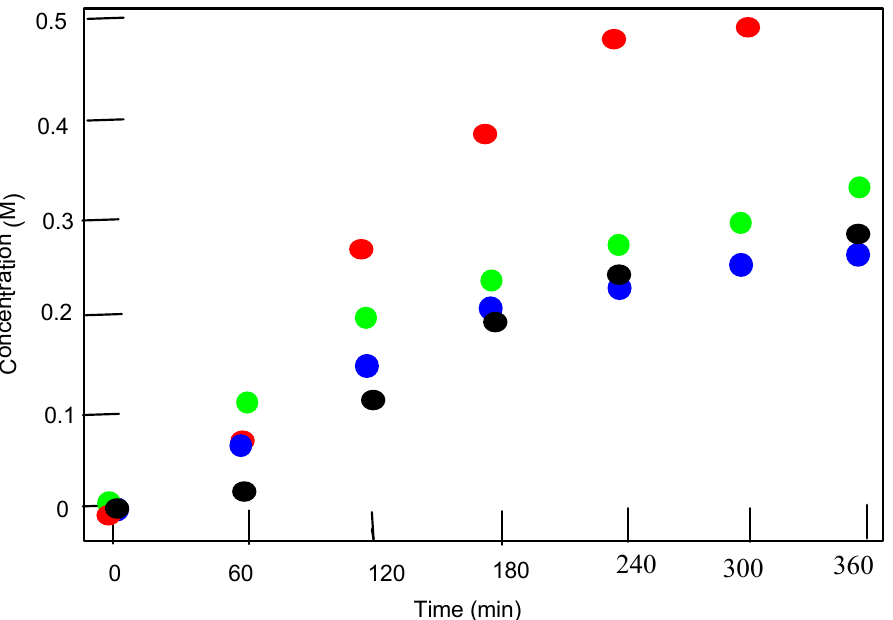
Figure 11. Accumulation of cyclohexanone (yield = 60%, TON = 600) in oxidation of cyclohexanol (0.5 M, green—curve 1), acetophenone (yield = 98%, TON = 980) in oxidation of phenylethanol (0.5 M, red—curve 2), 2-heptanone (yield = 48%, TON = 480) in oxidation of 2-heptanol (0.5 M, blue—curve 3) and 2-hexanone (yield = 50%, TON = 500) in oxidation of 2-hexanol (0.5 M, black—curve 4) with tert- butyl hydroperoxide (1.5 M, 70% aqueous) catalyzed by compound 4 (5 × 10 − 4 M) in MeCN at 50 °C.